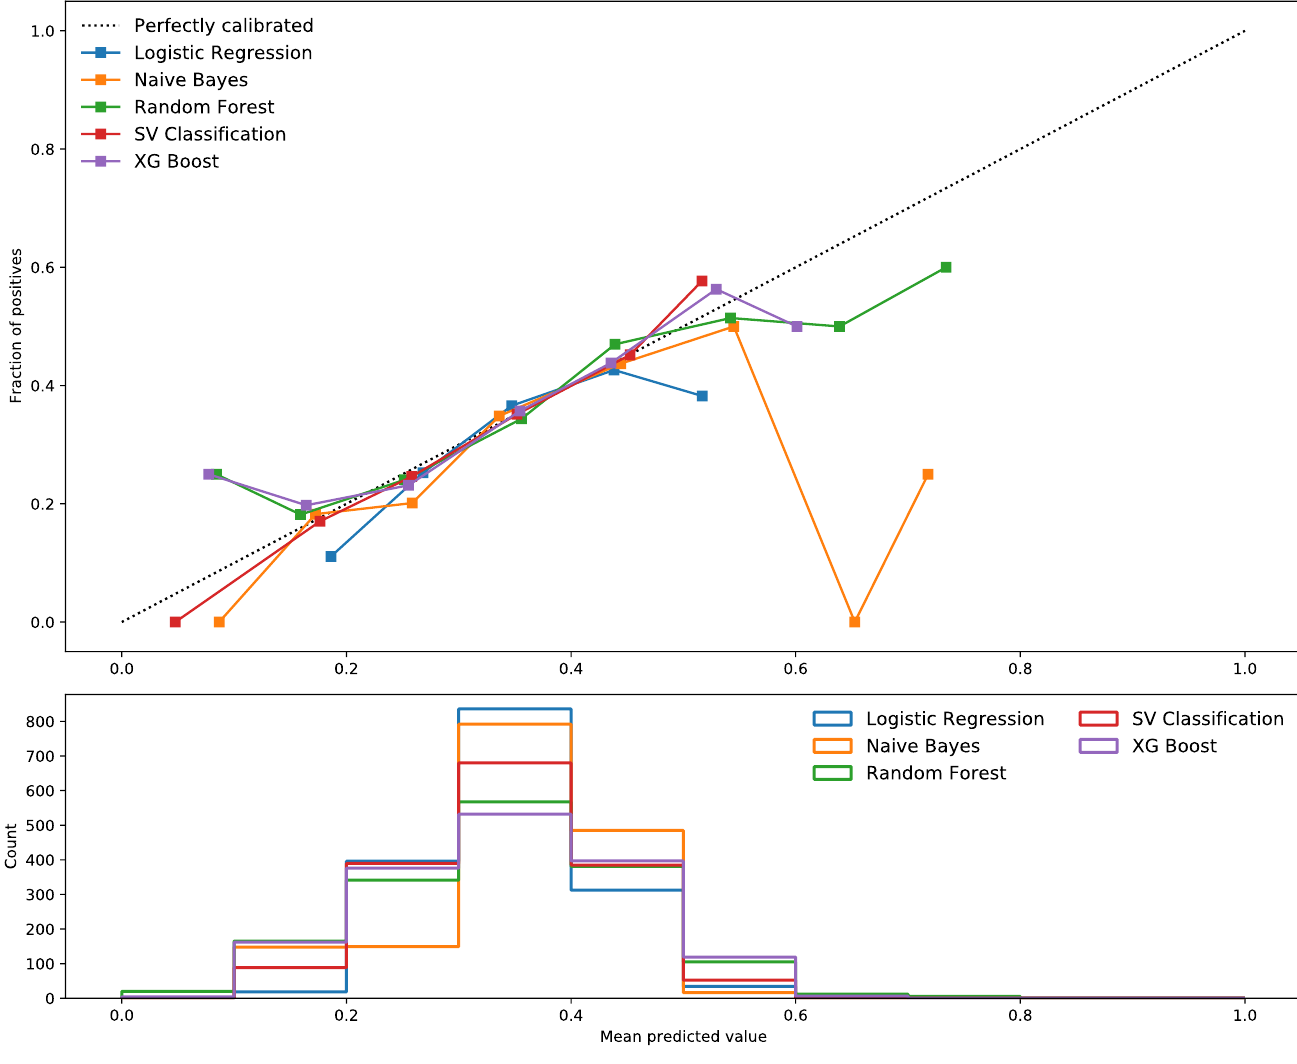
Figure 3. Calibration curve for ML algorithms.